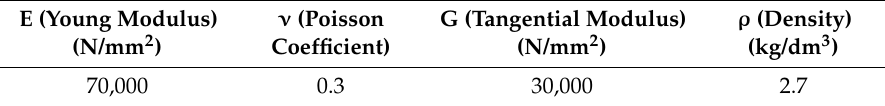
Figure 3. Buckling analysis model: boundary condition and load cases. Table 2. FEM simulation parameters.